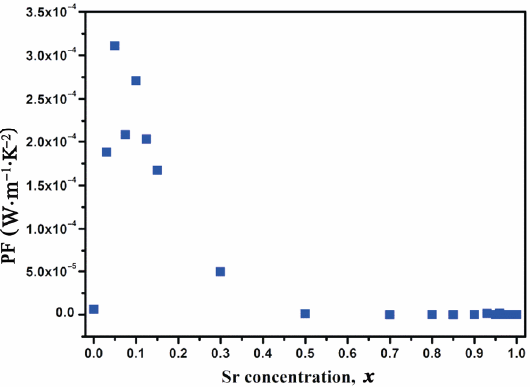
Fig. 10 Variation of thermal diffusivity as a function of x for La 1– x Sr x CoO 3 with 0 ≤ x ≤ 1 at 323, 573, 873, and 1000